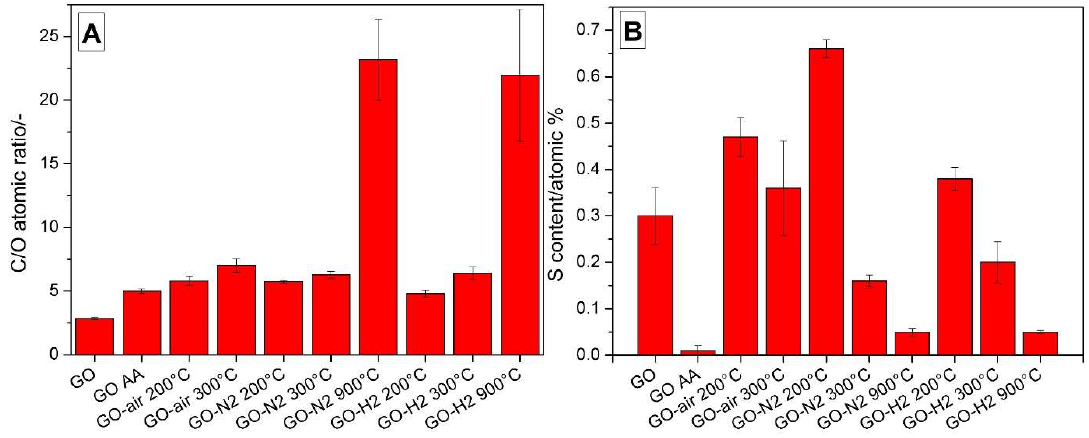
Figure 5. C/O ratio ( A ) and sulfur content ( B ) of the samples from EDX measurements.